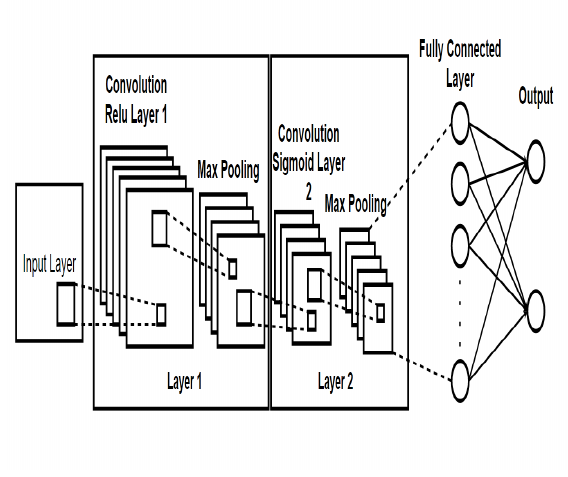
Figure 6. Training of CNN model Figure 7. Graphical user interface of the proposed